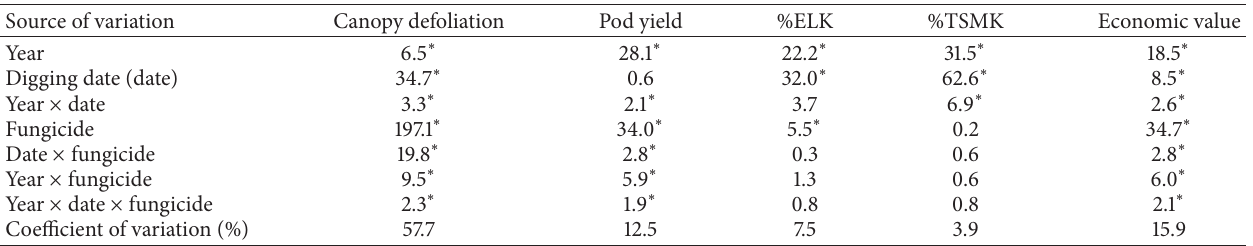
Table 6: Analysis of variance ( 𝐹 -value) for percent canopy defoliation (%), pod yield (kg/ha), percentages of extra large kernels (%ELK) and total sound mature kernels (%TSMK), and economic value ($/ha) for the cultivar Gregory as influenced by the interaction of digging date and fungicide regime for experiments conducted from 2005 to 2012.